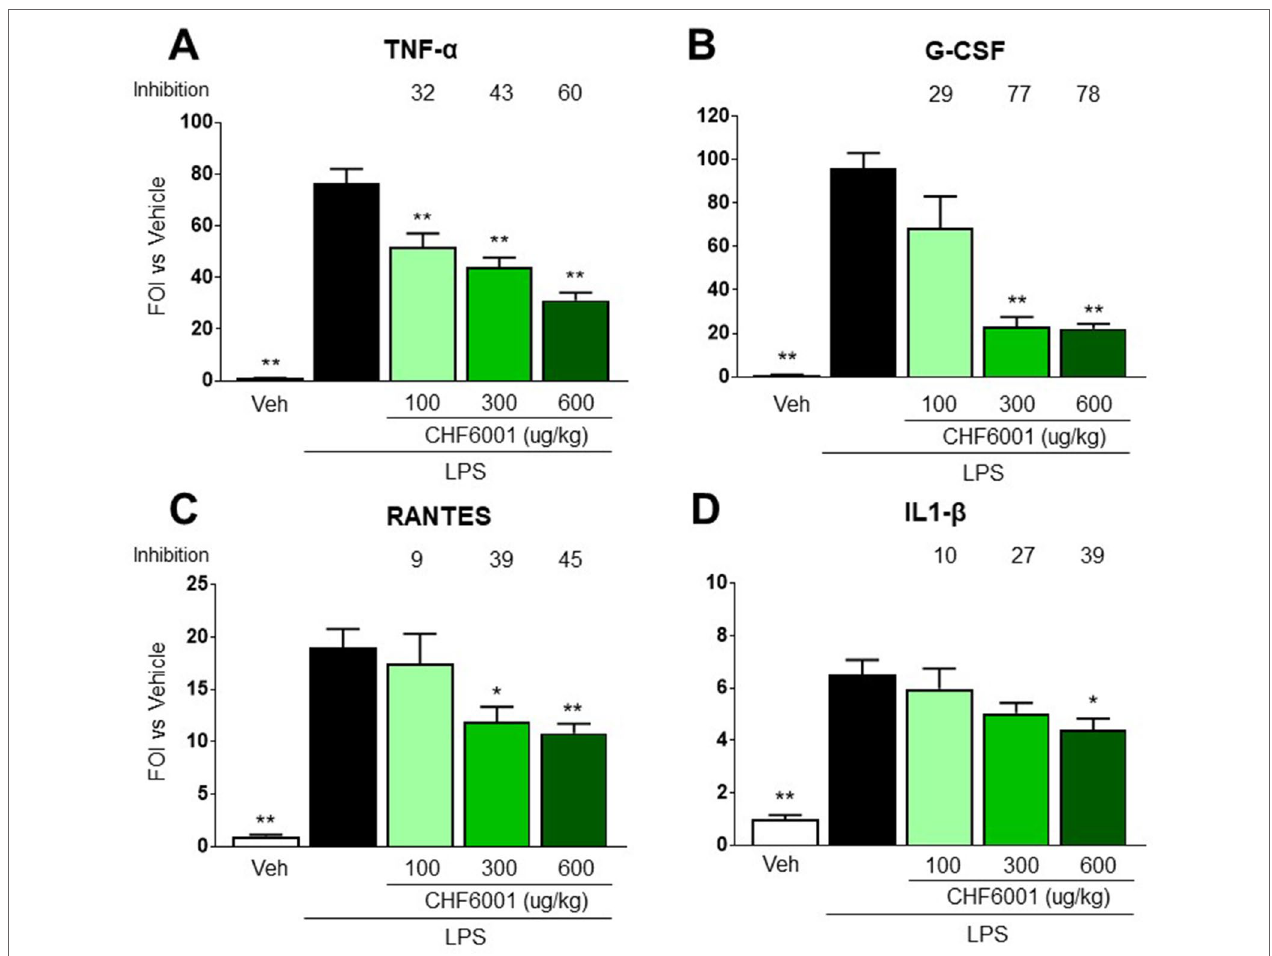
FIGURE 5 | Effects of CHF6001 on cytokine concentrations in bronchoalveolar lavage fluids. Transient NF-kB-luc transgenic mice were pretreated with saline or CHF6001 (100–600 µg/kg) 1 h prior to lipopolysaccharide (LPS) and sacrificed 24 h after tracheal instillation of LPS. Cytokines were assessed using a Bio-Plex™ Cytokine Assay Kit as described in METHODS . (A) Tumor necrosis factor alpha (TNF-α). (B) Granulocyte colony-stimulating factor (G-CSF). (C) Regulated on activation, normal T cell expressed and secreted (RANTES). (D) IL-1β. Values are shown as the mean ± SEM, n = 6 for each group. * P < 0.05, ** P <0.01 versus LPS group (Dunnett’s